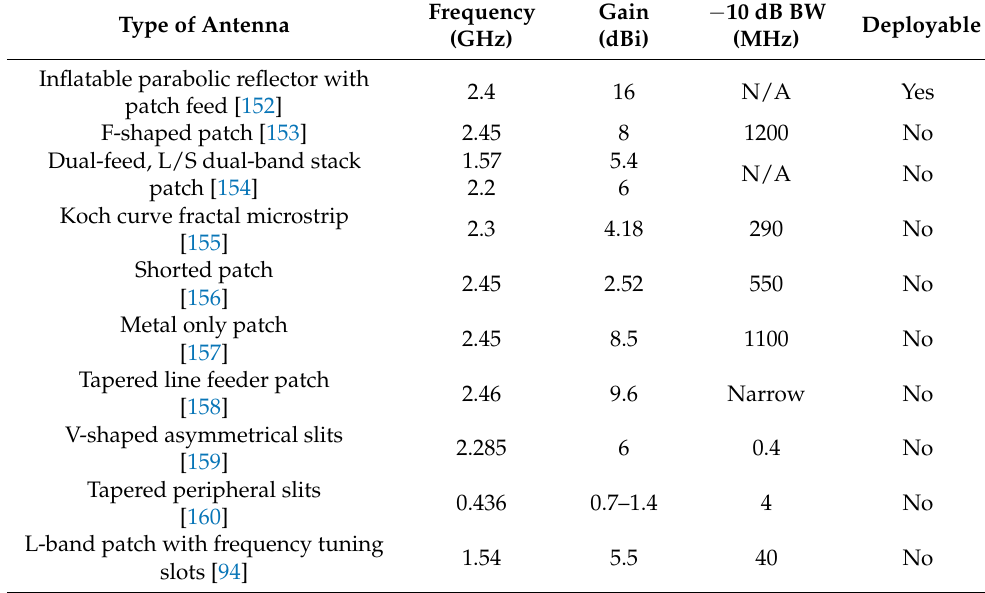
Table 7. Performance of planar antennas. Type of